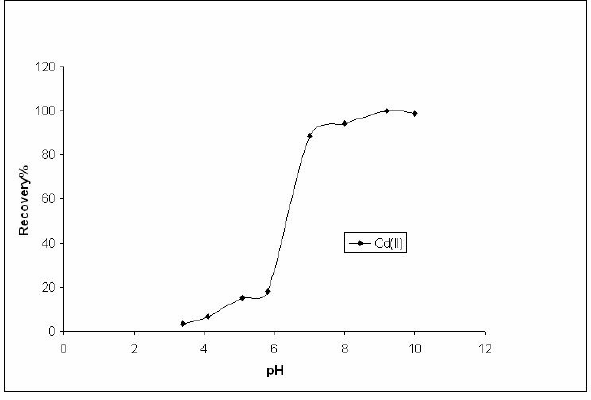
Figure 5. Effect of pH on analyte